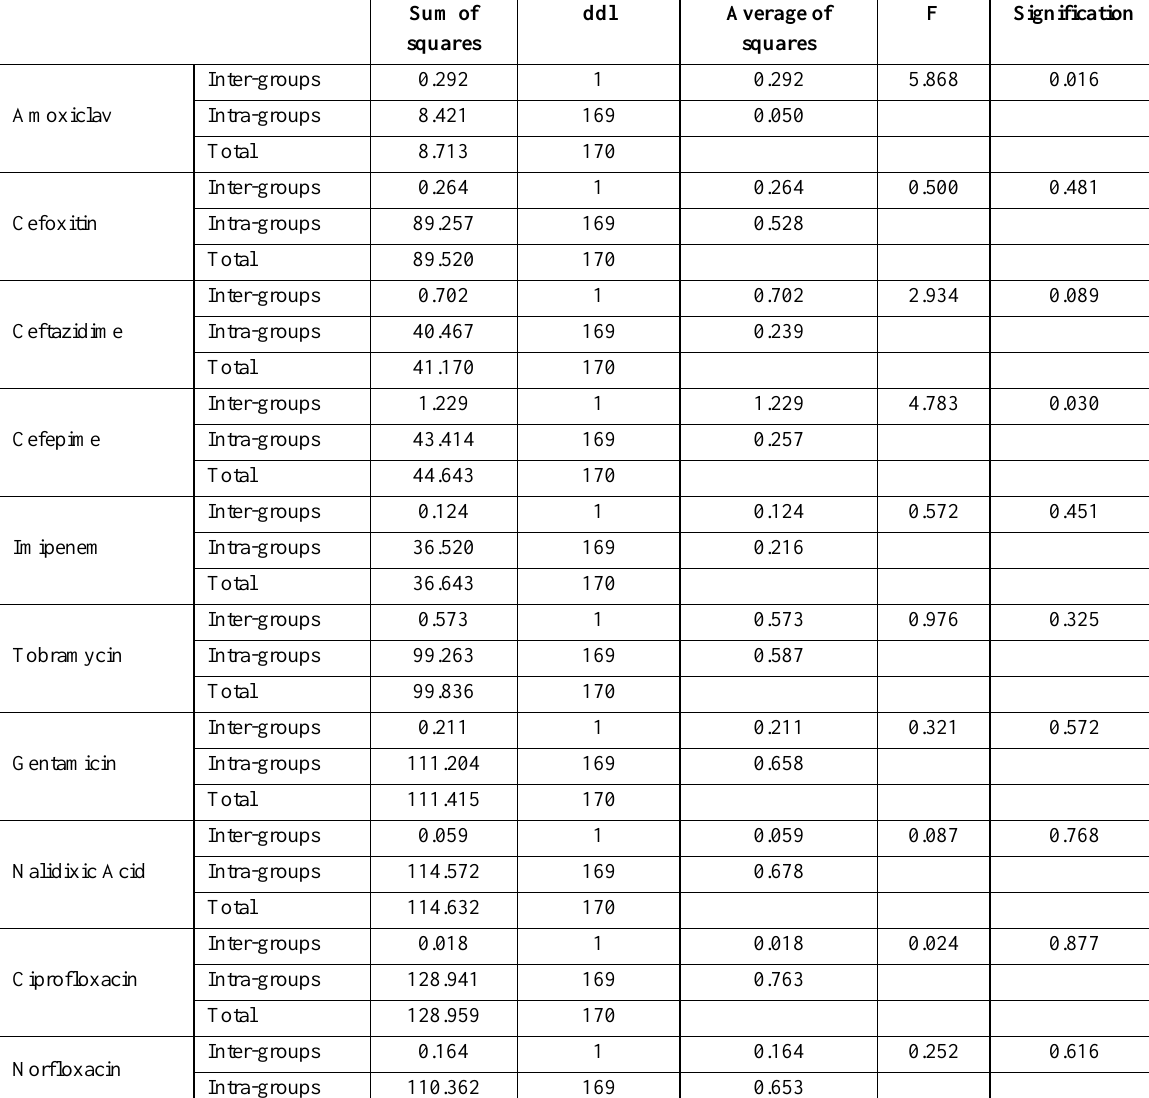
Table 1. Analysis of variances (ANOVA) based on comparisons of antibiotic activities among environmental and clinical isolates of Escherichia coli, Pseudomonas spp., Salmonella